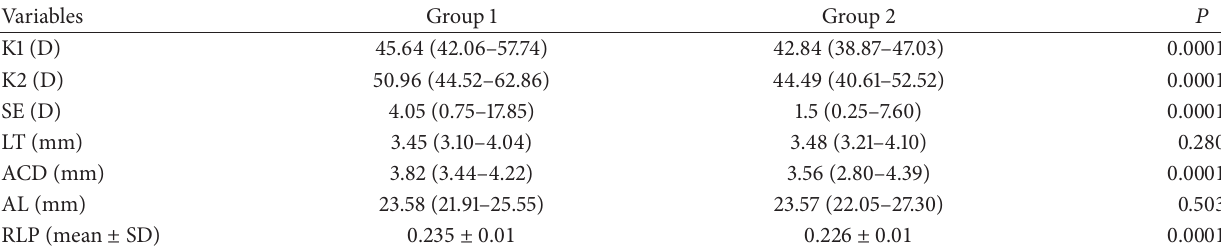
Table 3: Noncycloplegic situation between groups.